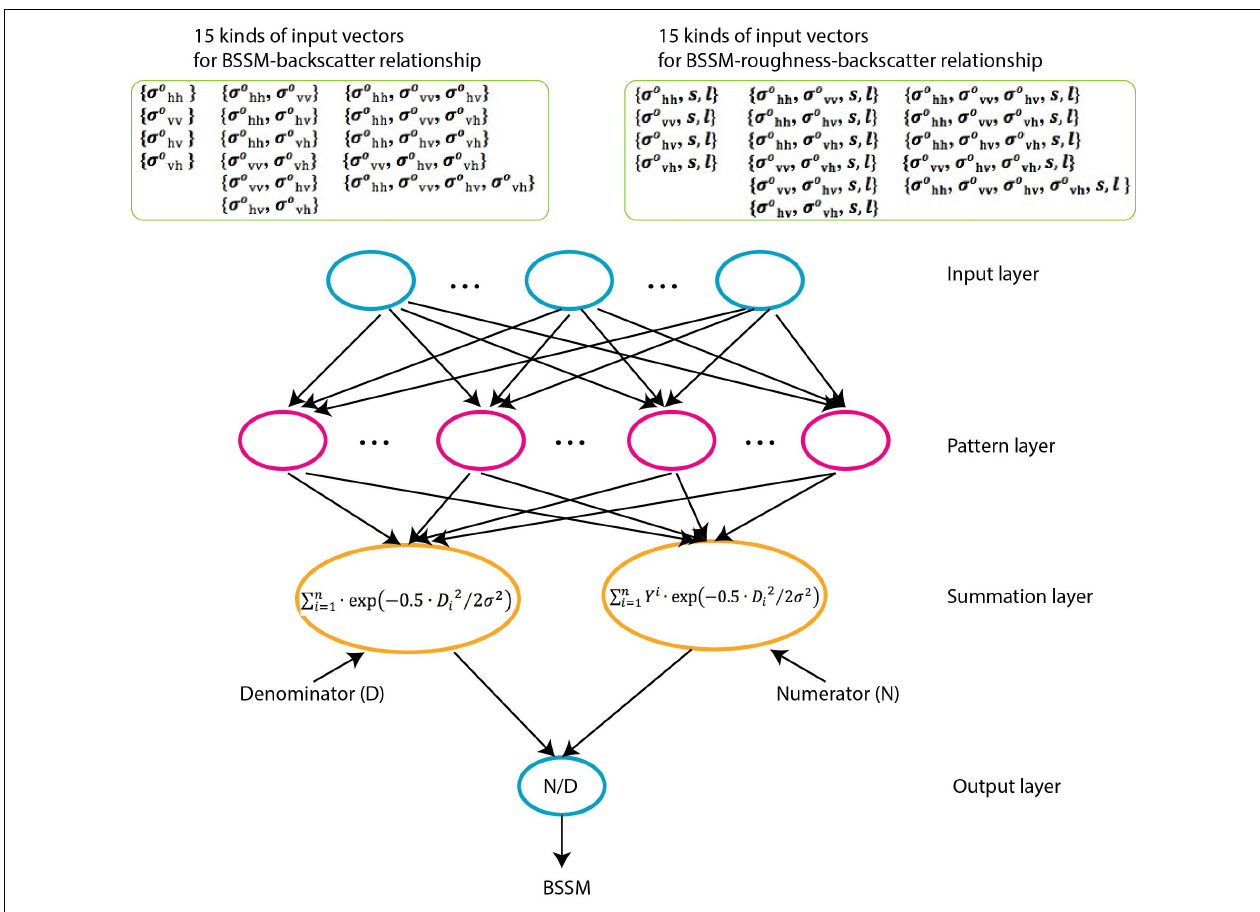
FIGURE 2 | GRNN frameworks for bare surface soil moisture retrieval from backscattering coefficients without and with auxiliary surface